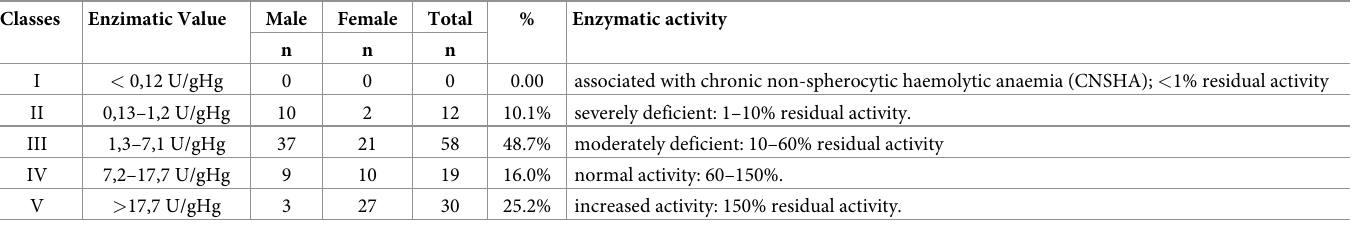
Table 4. Classification of G6PD deficiency by sex in Cabo Verde in according with the